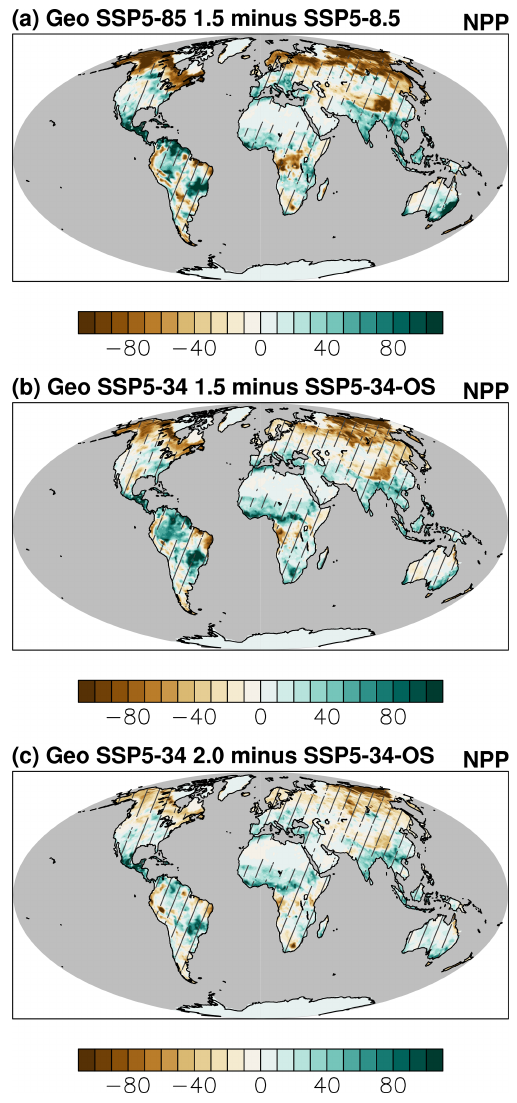
Figure 8. Ensemble mean land-accumulated NPP difference (gCm − 2 yr − 1 ) between 2060 and 2069 for Geo SSP5-85 1.5 and SSP5-85 (a) , Geo SSP5-34-OS 1.5 and SSP5-34-OS (b) , and Geo SSP5-34-OS 2.0 and SSP5-34-OS (c) . Hatched regions are ar- eas not significant with 95% confidence, assuming normally dis- tributed data.